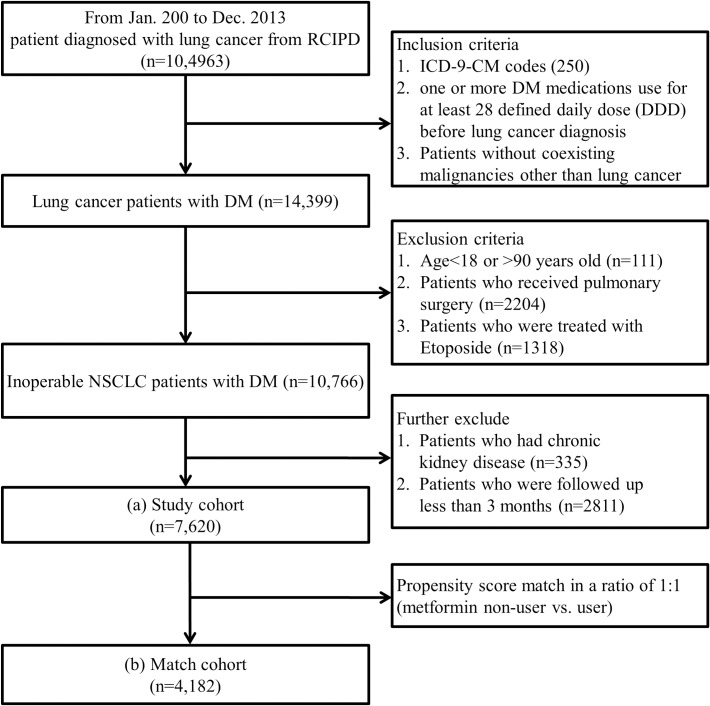
Flow chart of patient selection from the Registry for Catastrophic Illness Patient Database (RCIPD).ICD-9-CM, International Classification of Diseases, Ninth Revision, Clinical Modification; NSCLC, non-small cell lung cancer.